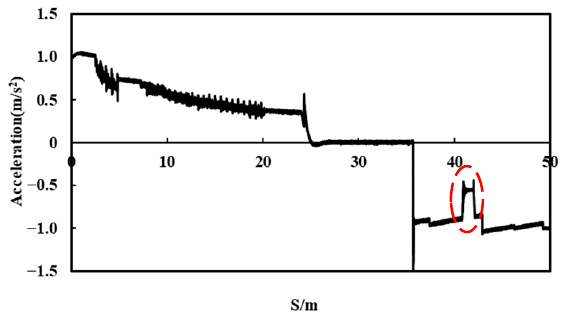
Figure 13. The whole acceleration of the train when the fault occurs during deceleration process.